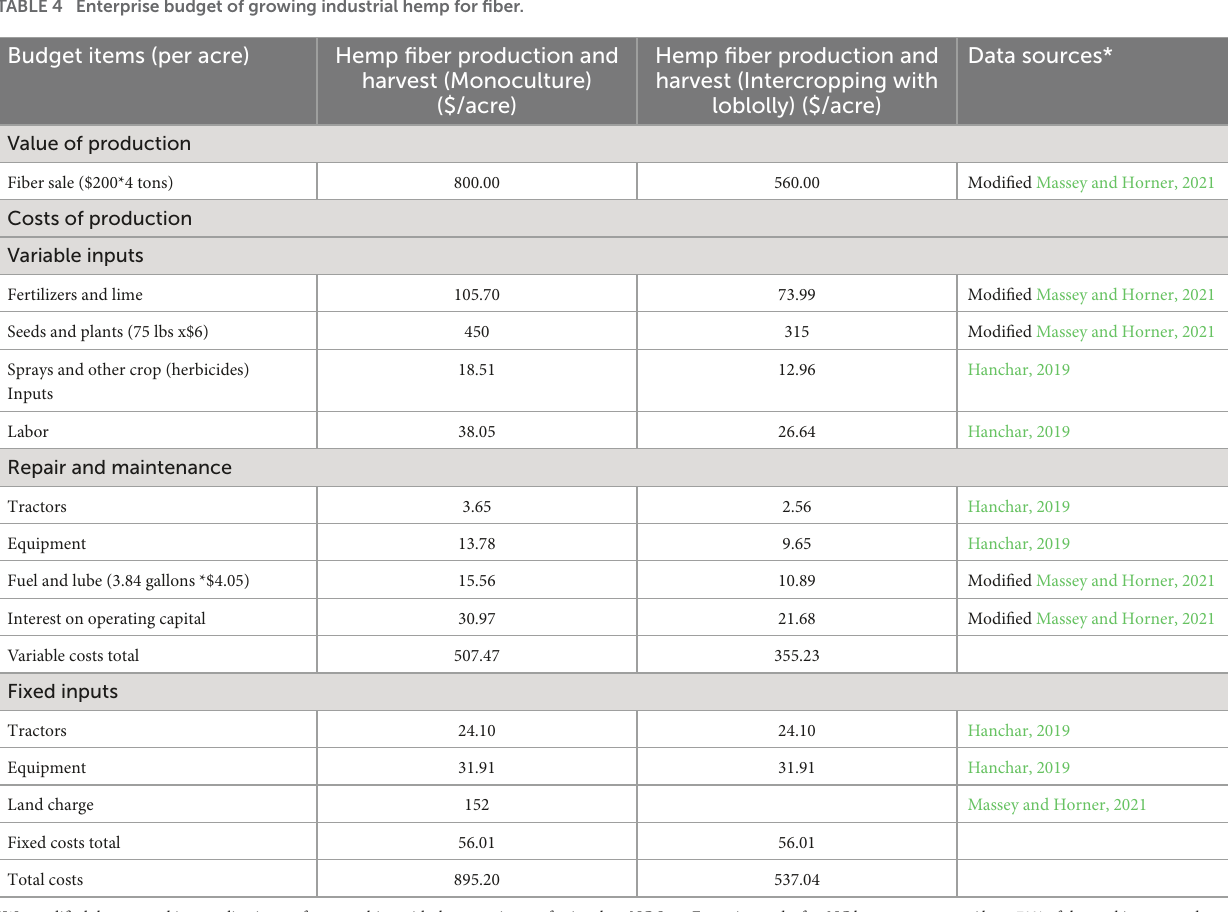
TABLE 4 Enterprise budget of growing industrial hemp for